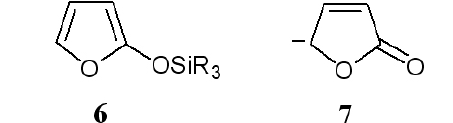
Figure 3. Common starting materials for the synthesis of various functionalized 2-(5H)-furanone derivatives.